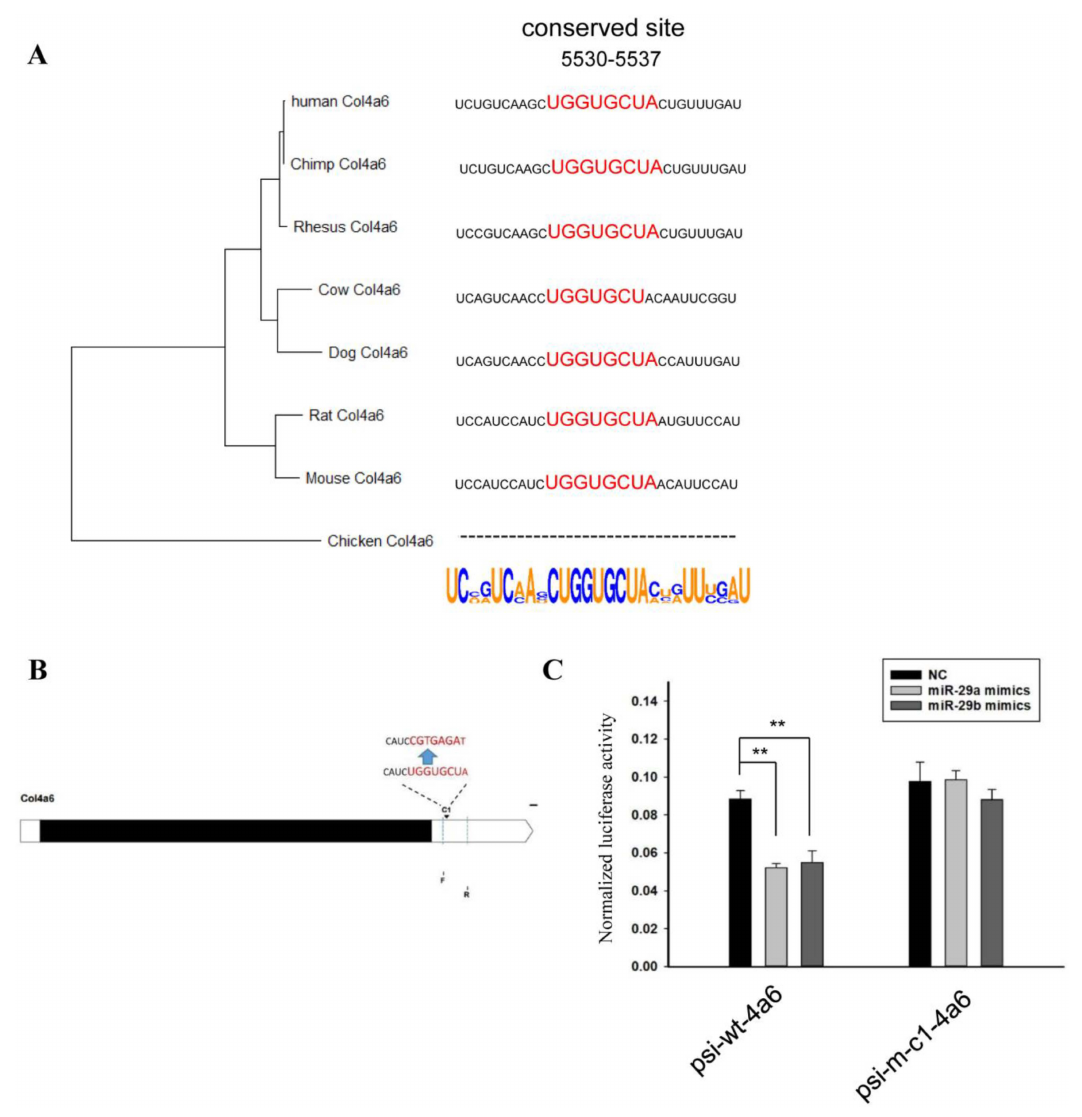
Figure 6. MiR-29 directly regulates the 3 (cid:48) UTR of Col4a6 . ( A ) Phylogenetic tree constructed from the 3 (cid:48) UTRs of Col4a6 in multiple species. Analysis of miR-29 binding site and flanking sequences in the 3 (cid:48) UTRs of Col4a6 in multiple species. ( B ) Schematic diagram of complementary sequence site and primer sites. ( C ) The effect of miR-29a or miR-29b mimics on the relative luciferase activity of the psi-wt-4a6 vector and the psi-m-c1-4a6 vector was examined. The data are shown as the mean ± SEM ( n = 3). **, p <